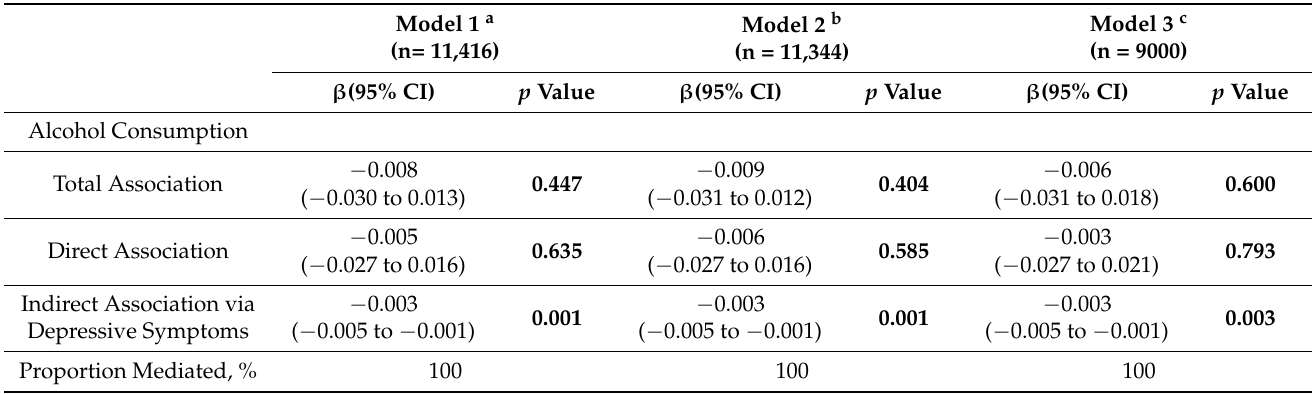
Figure 3. The trajectory of late-life cognitive decline with age. Table 4. Adjusted direct and indirect associations of alcohol consumption with global cognitive function mediated via depressive